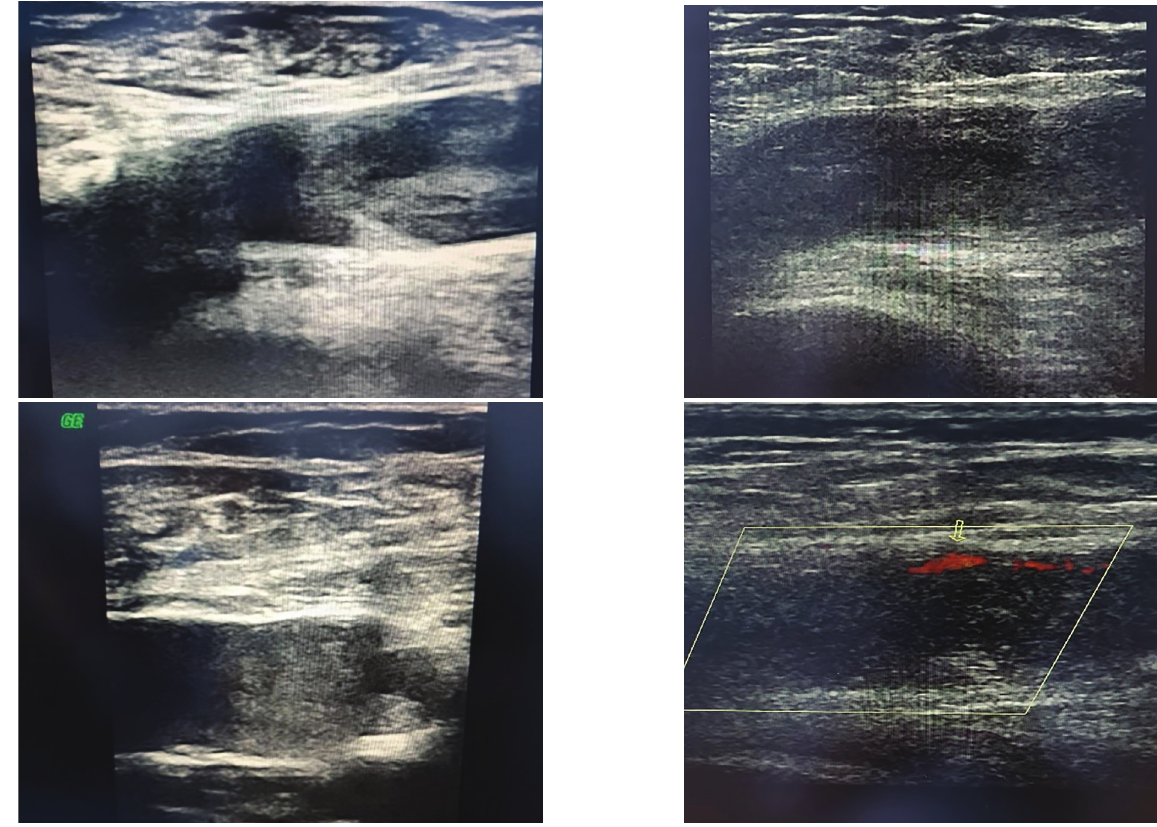
Figure 2 - The effect of "spontaneous contrast" in the lumen of the femoral vein